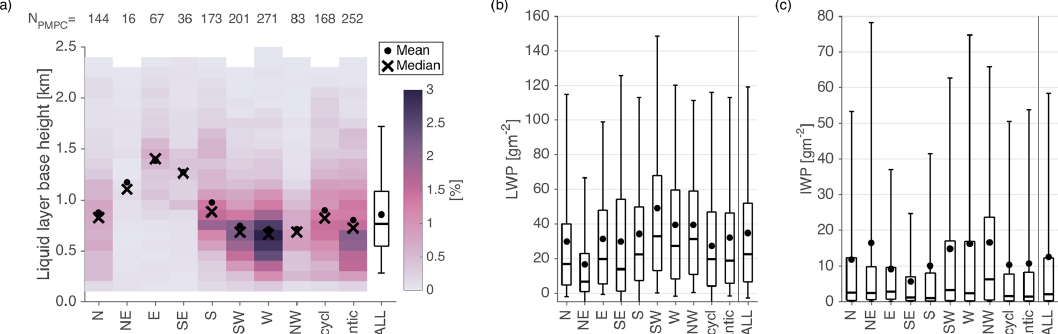
Figure 7. Height of the P-MPC liquid layer base (a) , the LWP (b) and IWP (c) distributions for each weather type, and all P-MPCs. The number of P-MPC cases for each weather type is given in (a) . The box shows the 25th, 50th, and 75th percentiles, the dot the mean, and the whiskers the 5th and 95th percentiles. The medians for different weather types were found to differ on a 95% confident level.